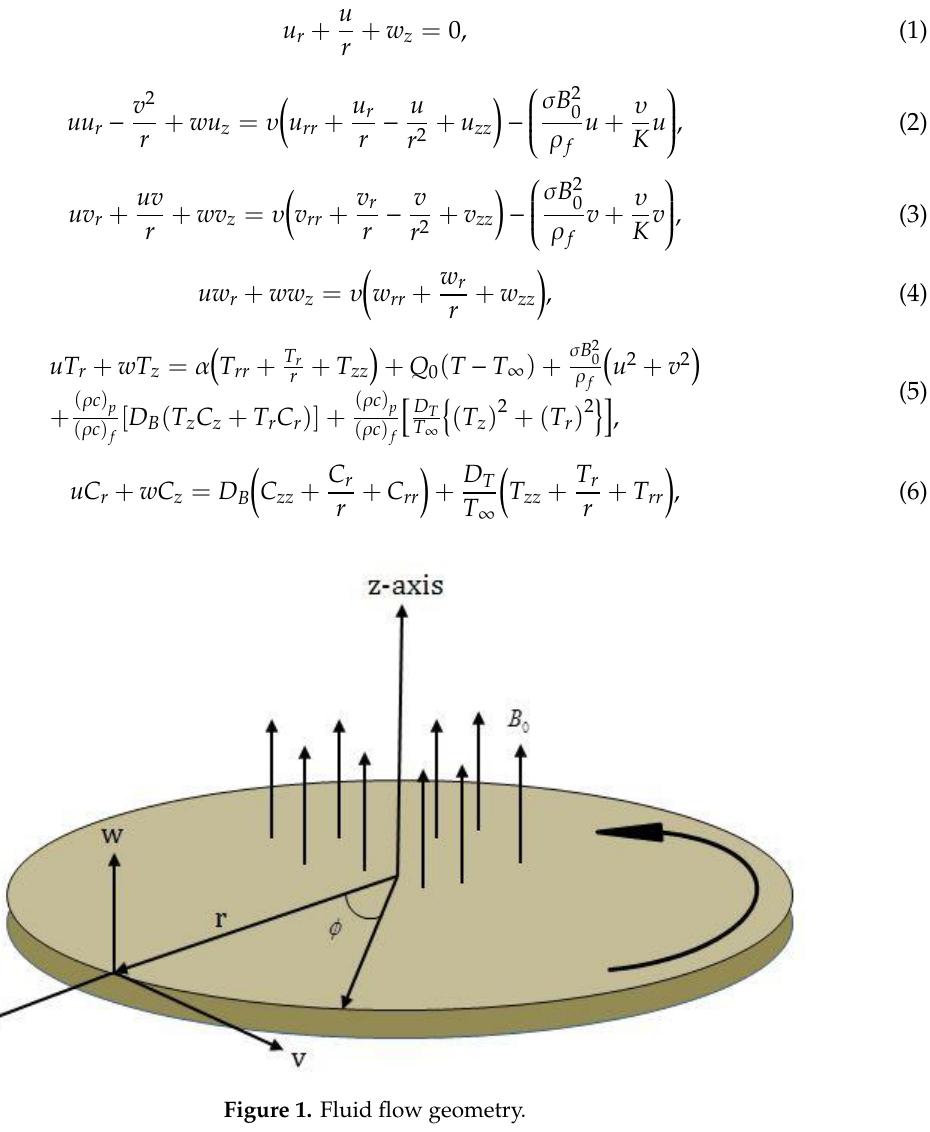
Figure 1. Fluid flow geometry.